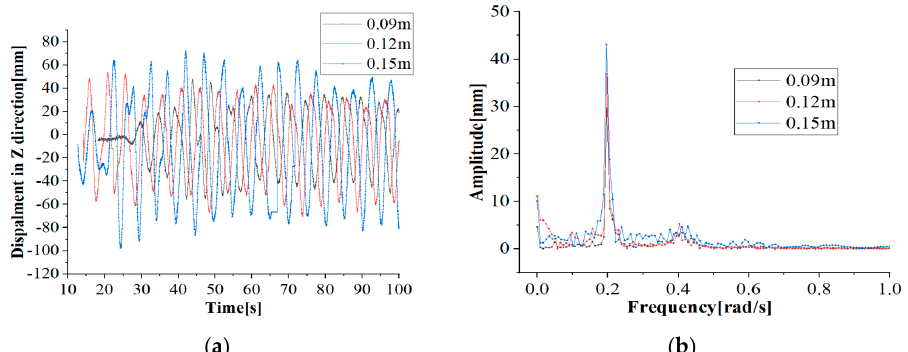
Figure 19. Heave response of the pedestal with different wave heights at 0.20 Hz. ( a ) Heave; ( b ) heave frequency domain curve.